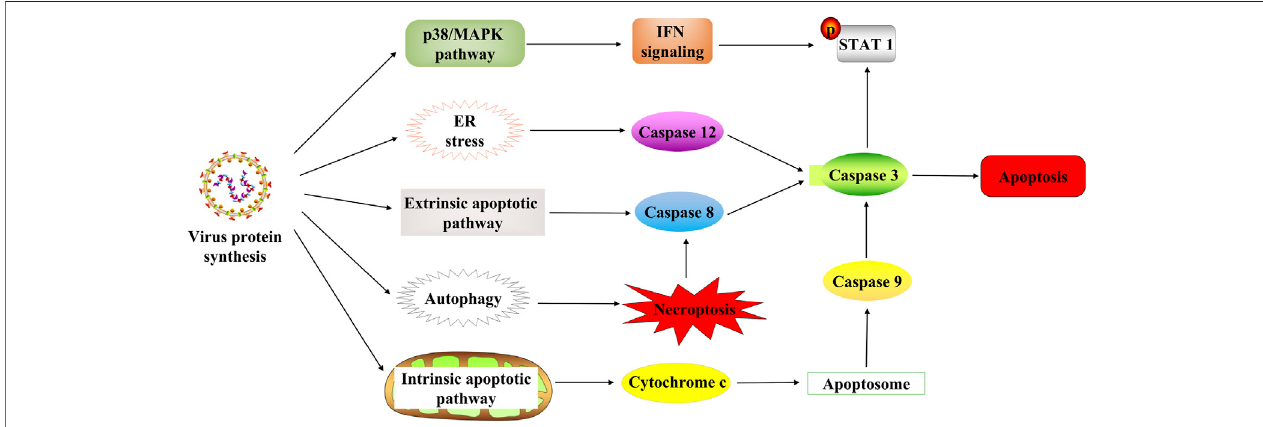
FIGURE3| NDV-induced celldeathin tumor cells. NDVregulatescelldeaththrough multiple mechanisms after infection with tumor cells, including the p38/MAPK pathway, ER stress, apoptosis pathway, and autophagy pathway. STAT1, signal transducer and activator of transcription 1; ER, endoplasmic